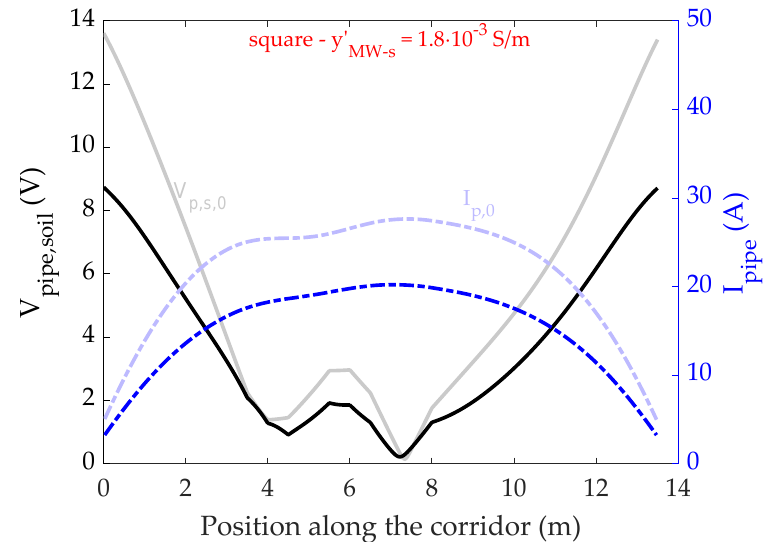
Figure 5. Magnitude of induced pipe-to-soil voltage and longitudinal pipe current along the corridor, when 4 equispaced square mitigation wires are employed.